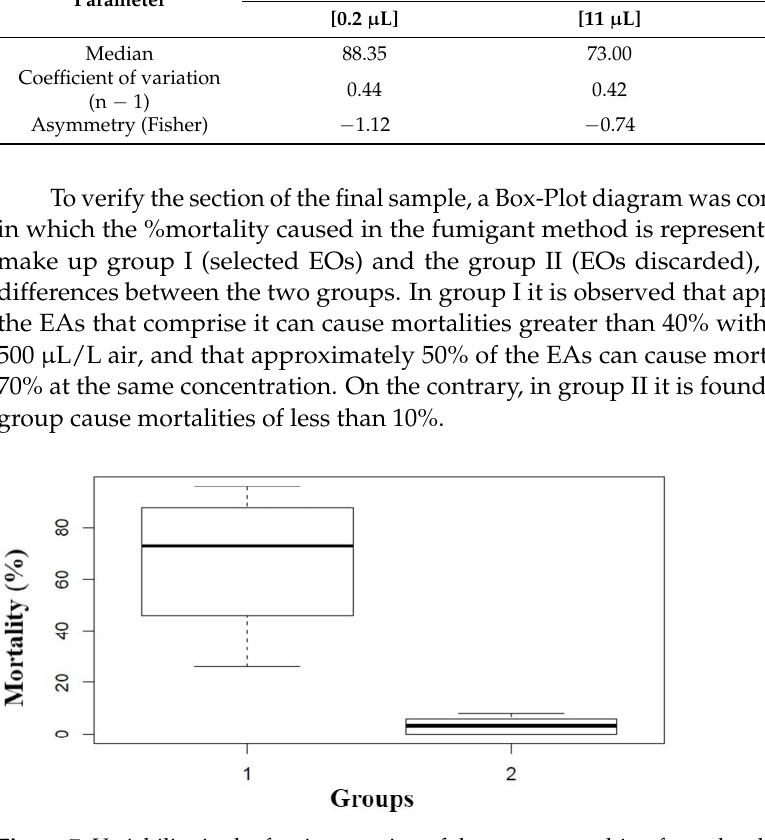
Table 3. Fumigant toxicity for the 14 EOs, expressed as median lethal concentrations (LC 50 ). Species